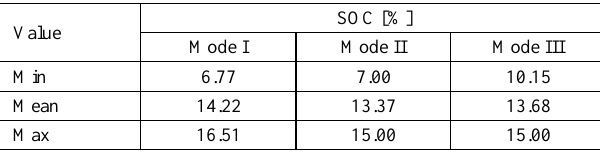
Table 6. SOC changes in the WLTC test in terms of different drive system control algorithms